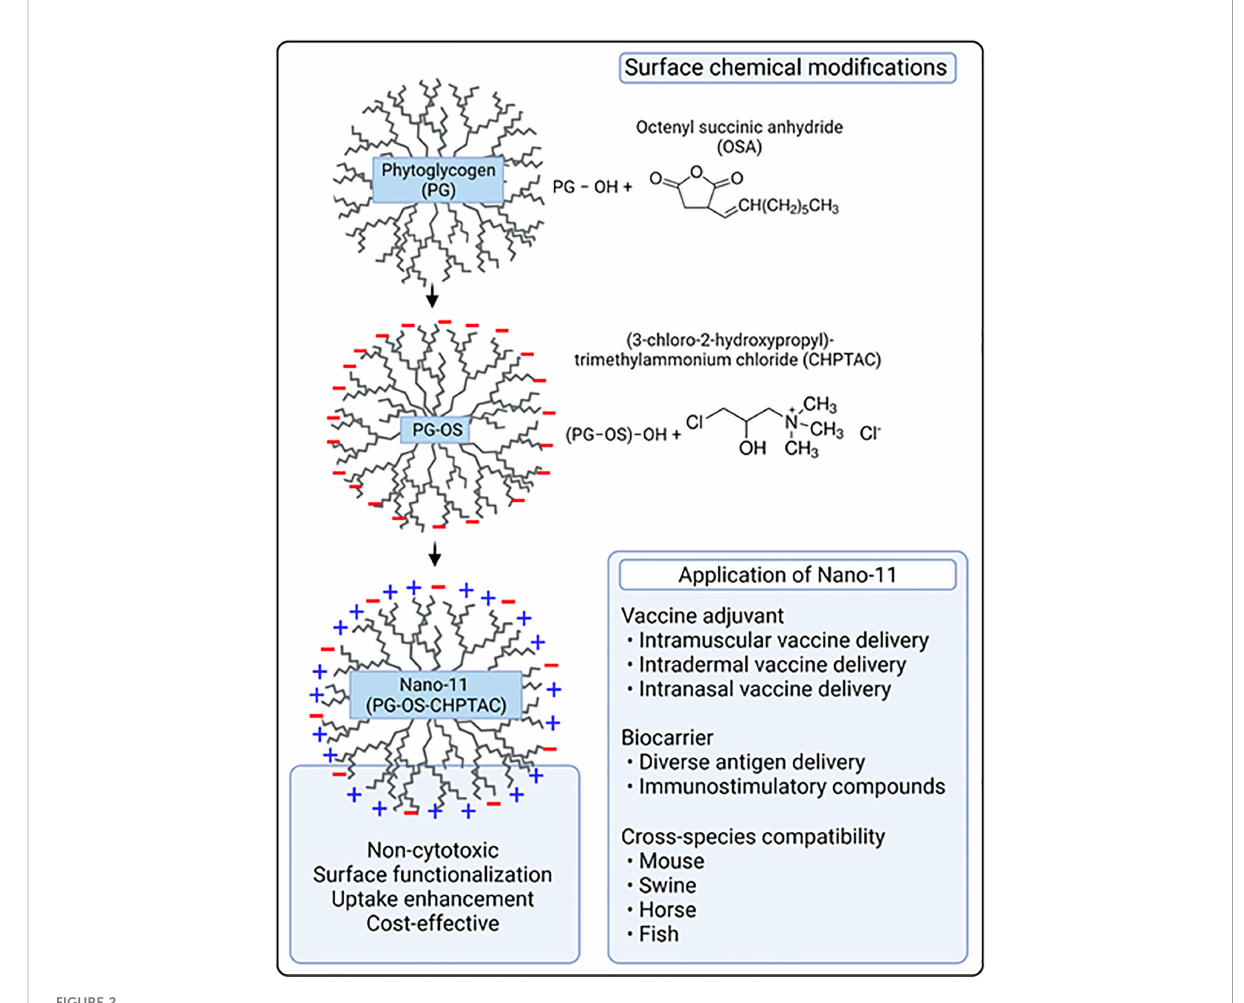
FIGURE 2 Summary of Nano-11 preparation and